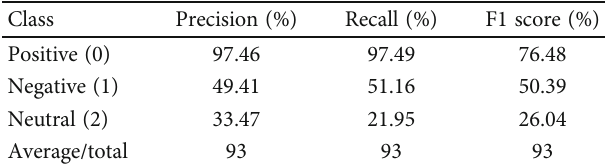
Table 14: Metrics using DSC for sentiment classi fi cation